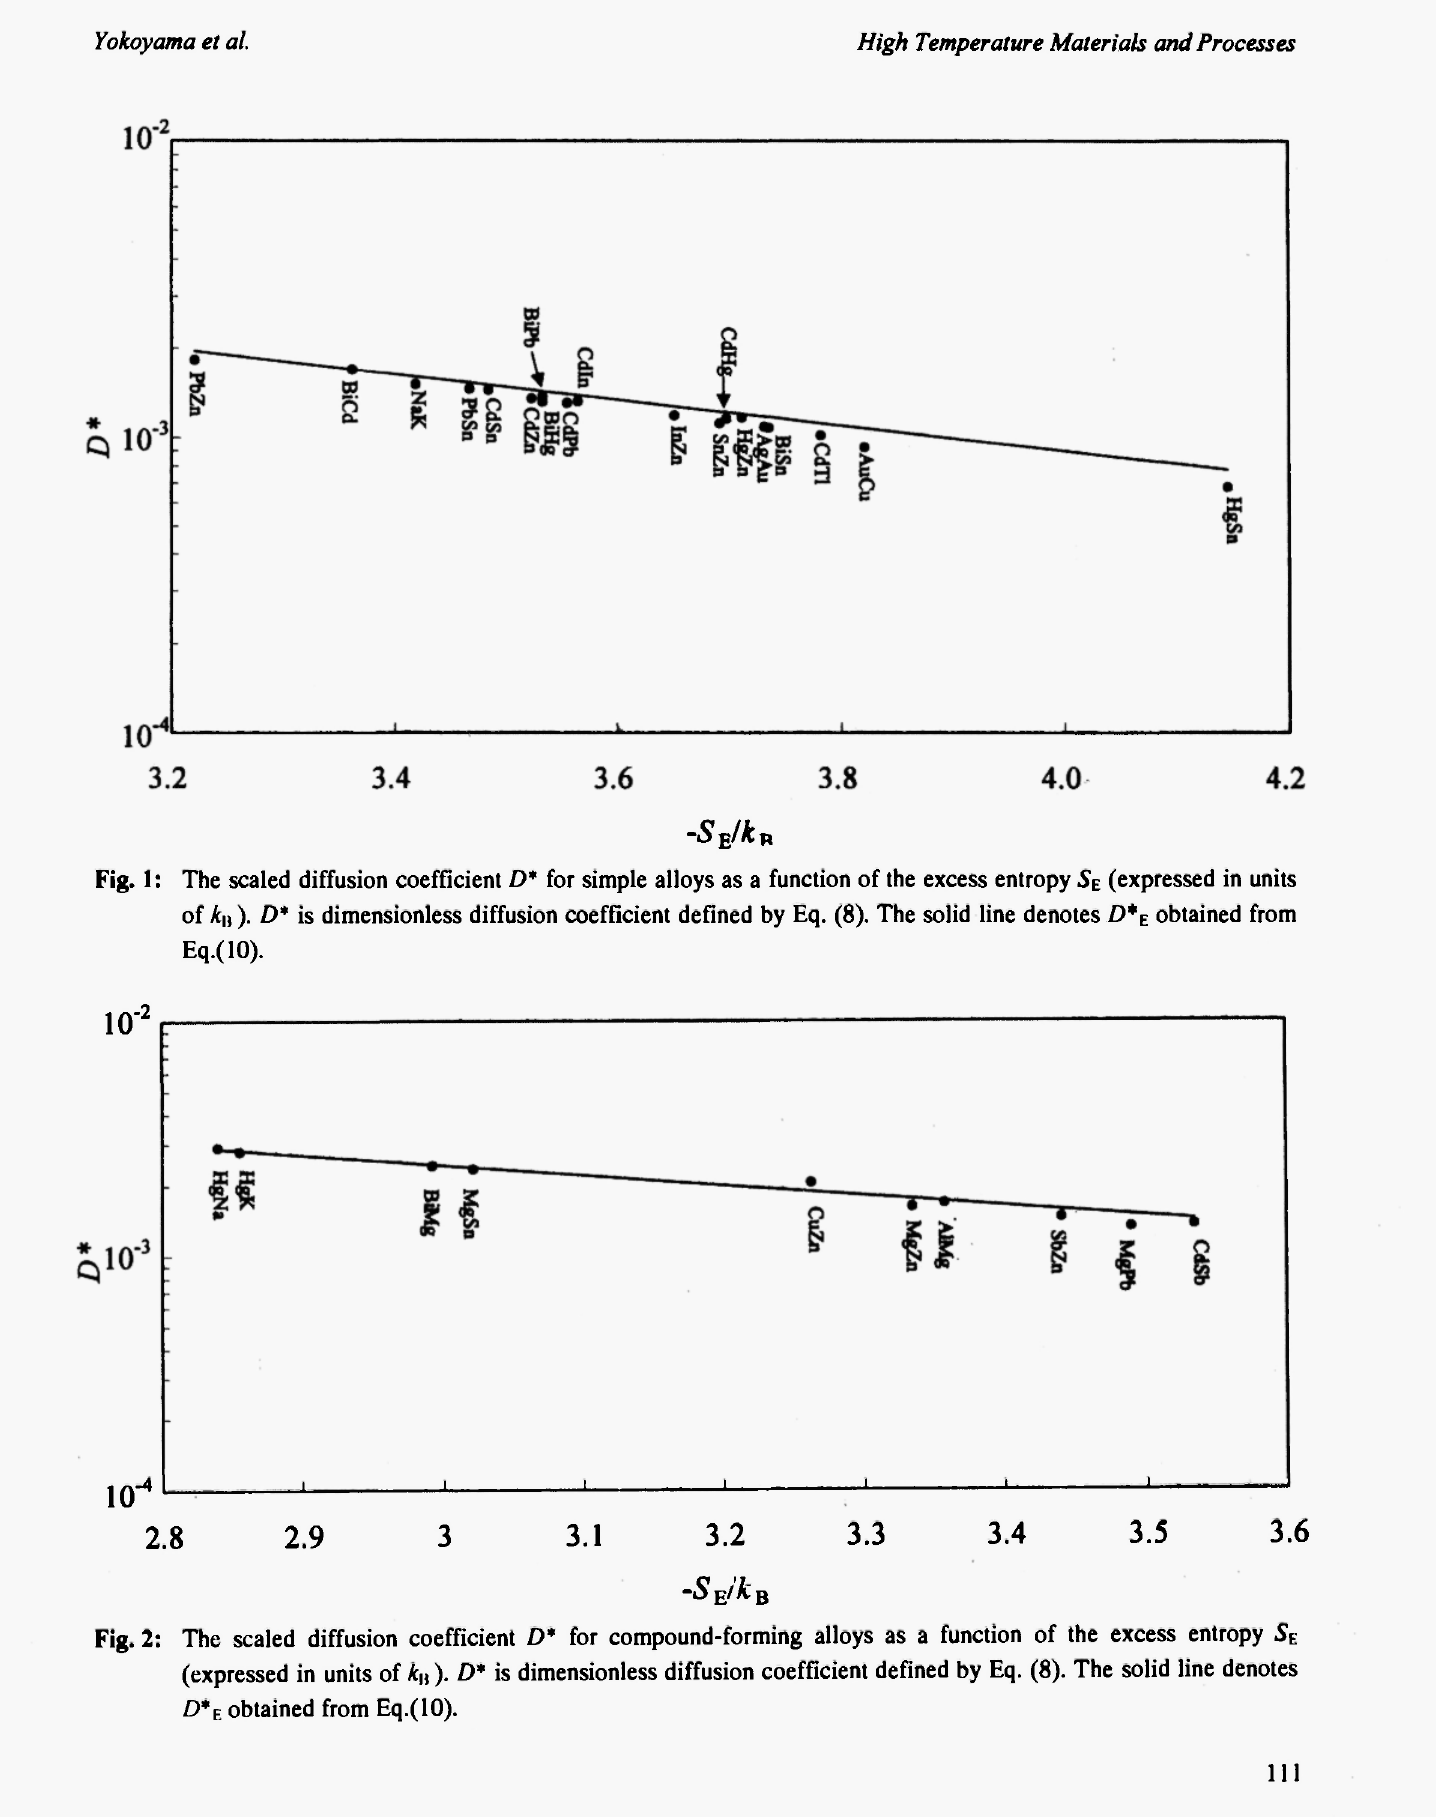
Fig. 2: The scaled diffusion coefficient D* for compound-forming alloys as a function of the excess entropy S E (expressed in units of ). D* is dimensionless diffusion coefficient defined by Eq. (8). The solid line denotes D* ε obtained from